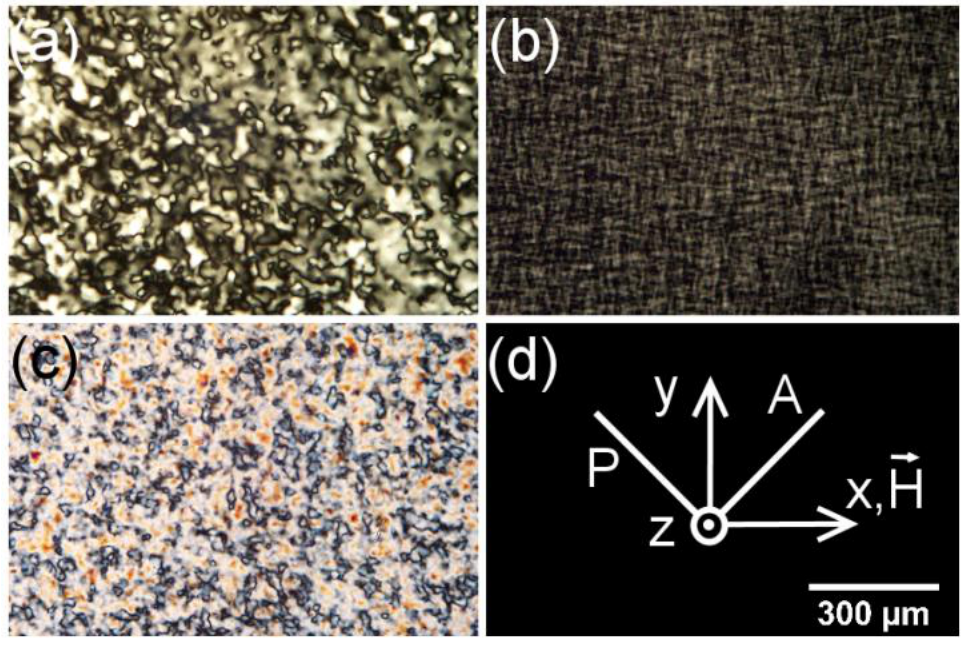
Figure 8. Textures of N -dodecanoyl-glycinate (KDDGly)/Na mixture under a magnetic field of 0.3 kG: ( a ) N transition at ~30.1 °C; and ( c ) N are the directions of the polarizer, analyzer and magnetic field, respectively.